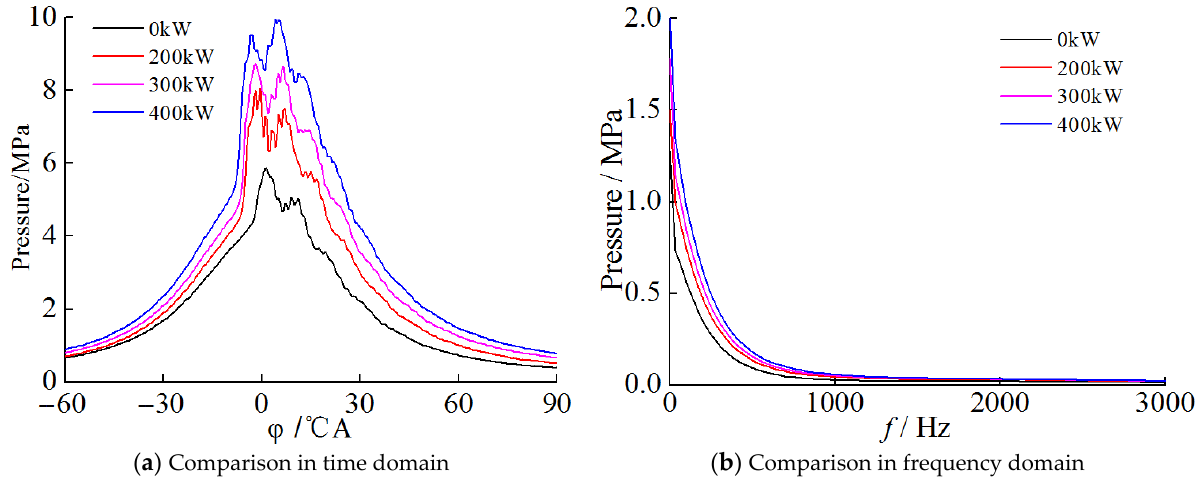
Figure 12. Time and frequency analysis of combustion pressure under the speed of 1200 rpm with different power.